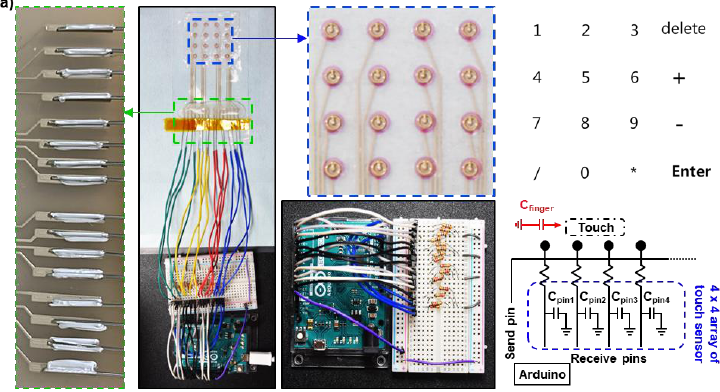
Table 1. Comparison of different stretchable iPCB for stretchable electronic devices. RMI: reverse micelle induced, PDMS: